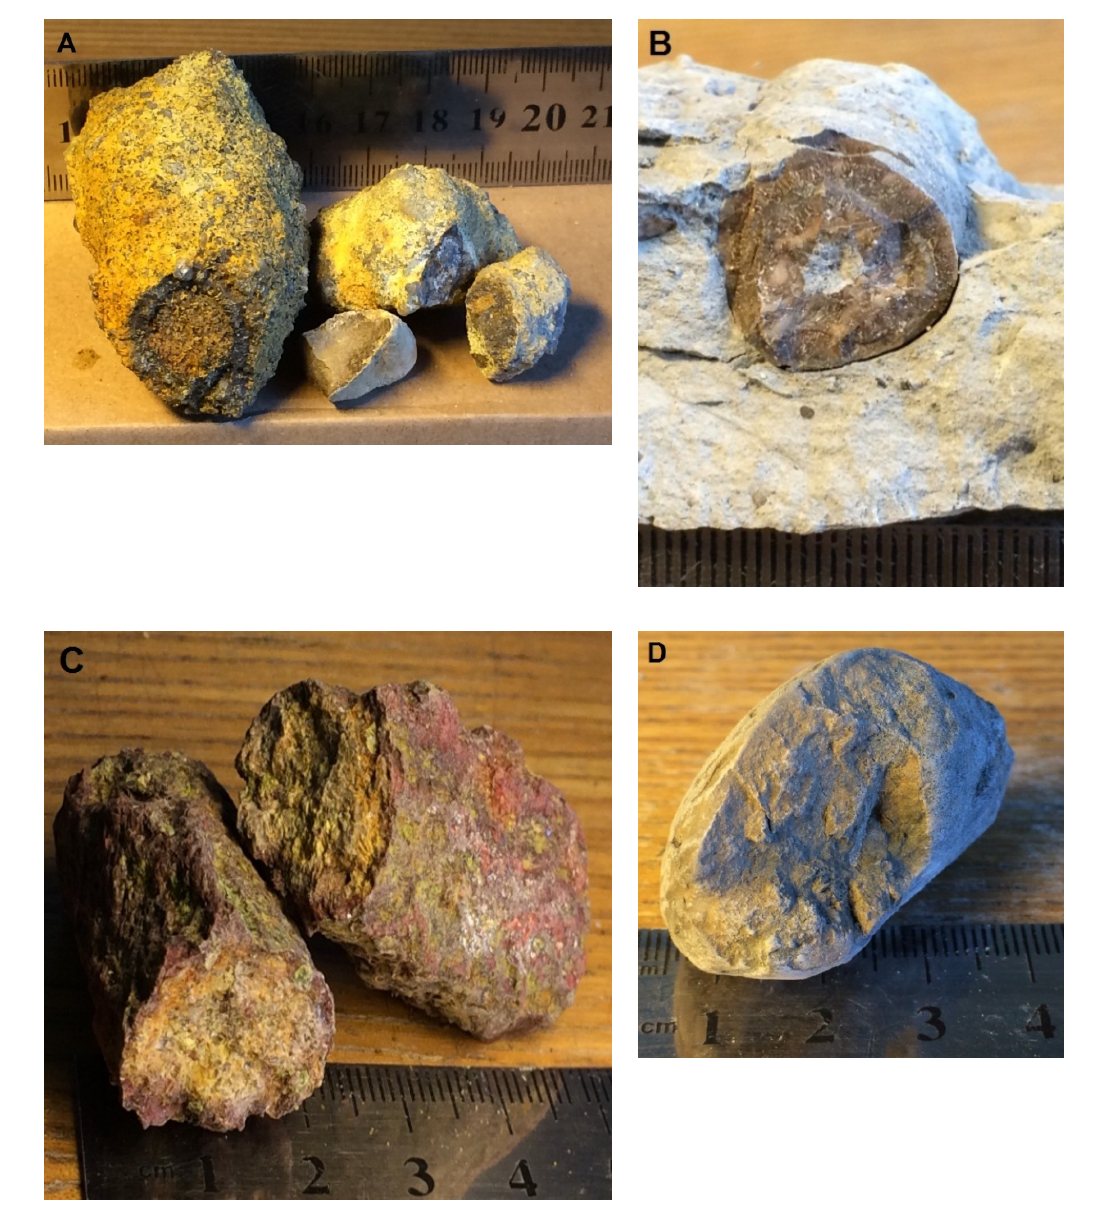
Figure 3. Phosphate components at the base of Bílá Hora Formation. ( A ) Phosphate nodule and tube-fills in hardground (B ř ezinka–Chvalka), ( B ) Phosphate coprolite (Úpohlavy quarry), ( C ) Phosphate tube-fill (Planany quarry), and ( D ) Phos- phatized bivalve mold (Pecínov quarry).